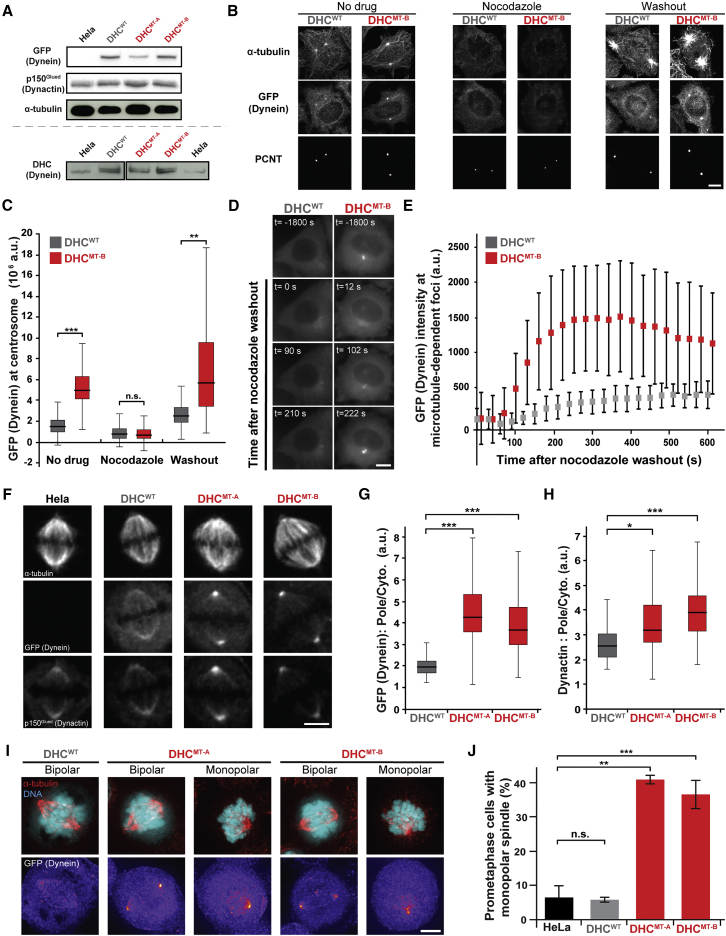
Phi-Particle Disruption Changes Dynein Localization and Causes Mitotic Defects in HeLa Cells(A) Western blots of lysates from HeLa cells and clonal HeLa cell lines stably expressing dynein BAC transgenes. The DHCWT cell line expresses a wild-type GFP-dynein HC (GFP-DHC) transgene. DHCMT-A/DHCMT-B are two independent cell lines expressing mutant GFP-DHC (R1567E and K1610E). Top: Blots against GFP, p150Glued, and α-tubulin. Expression levels of GFP (dynein) are similar in DHCWT and DHCMT-B. Bottom: Blots against DHC. Expression of GFP-DHC (upper band) is similar to or lower than endogenous DHC (lower band) in transgene cell lines. GFP-DHC (upper band) is absent in HeLa lysates.(B) Immunofluorescence with antibodies against α-tubulin, GFP, and pericentrin (PCNT) on DHCWT and DHCMT-B cell lines. G2-synchronized cells were fixed either before nocodazole treatment (No drug), after 30 min with 3.3 μM nocodazole or after washout of the nocodazole for 3 min. Scale bar, 10 μm.(C) Quantification of GFP intensity around individual centrosomes in cells from (B). DHCMT-B show GFP (Dynein) enrichment compared to DHCWT. The difference is abolished by nocodazole treatment and recovers after drug washout. ∗∗∗p < 0.001, ∗∗p < 0.01 in a Kruskal-Wallis test followed by paired Wilcoxon tests. n > 86 per condition, three independent experiments.(D) Still images from movies of DHCWT and DHCMT-B cells synchronized in G2 and treated with nocodazole (3.3 μM) for 30 min before washout. Time (t) is relative to start of the washout. Scale bar, 10 μm.(E) Quantification of the GFP intensity at microtubule-dependent foci in cells from (D) show that accumulation is greater and faster in DHCMT-B. n = 10 cells per condition, Mean ± SD shown.(F) Immunofluorescence of HeLa, DHCWT, DHCMT-A, and DHCMT-B metaphase cells with antibodies against α-tubulin, GFP, and p150Glued. Scale bar, 5 μm.(G and H) The ratio of GFP (Dynein, G) or p150 (Dynactin, H) intensity at individual spindle poles divided by the corresponding intensity in the cytoplasm for DHCWT, DHCMT-A, and DHCMT-B cells. Dynein and dynactin are enriched at spindle poles of DHCMT-A/B cells. ∗∗∗p < 0.001, ∗p < 0.025 in a Kruskal-Wallis test followed by paired Wilcoxon tests. n > 120 spindle poles per condition from three independent experiments.(I) Cells imaged with DAPI (DNA) and α-tubulin antibodies (top row) or GFP (bottom row; displayed with a “fire” lookup table) showing representative prometaphase phenotypes in DHCWT, DHCMT-A, and DHCMT-B cells. Scale bar, 5 μm.(J) Quantification of the average percentage of prometaphase cells with monopolar spindles in HeLa, DHCWT, and DHCMT-A/B cells shows that mutation of the phi-dynein interface leads to an increase in mitotic defects. Mean ± SD is shown, ∗∗∗p < 0.001, ∗∗p < 0.01 in a paired Student’s t test. n > 235 cells from three experiments.